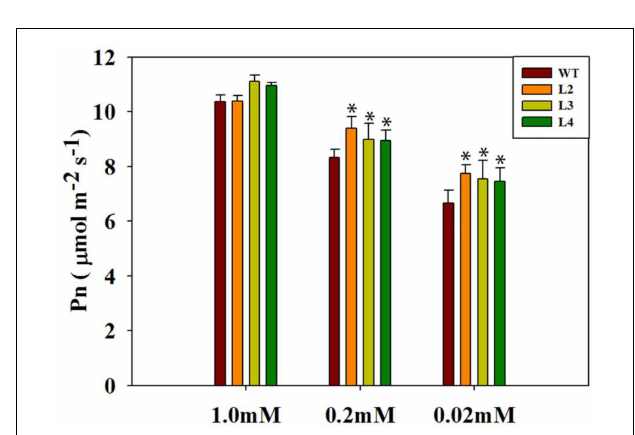
FIGURE 4 | Photosynthetic rate (Pn) of leaves of plants grown with normal or low phosphorus. Seedlings (after germination) were treated with 1.0 mM phosphorus (CK), 0.2 mM phosphorus and 0.02 mM phosphorus (LP) for 15 days under sand-culture system. The photosynthetic rate was measured by the CIRAS-3. Values are means ± SD. n = 6 for each genotype. Asterisks indicate significant differences compared with WT plants (Student’s t -test). ∗ P < 0.05; ∗∗ P <